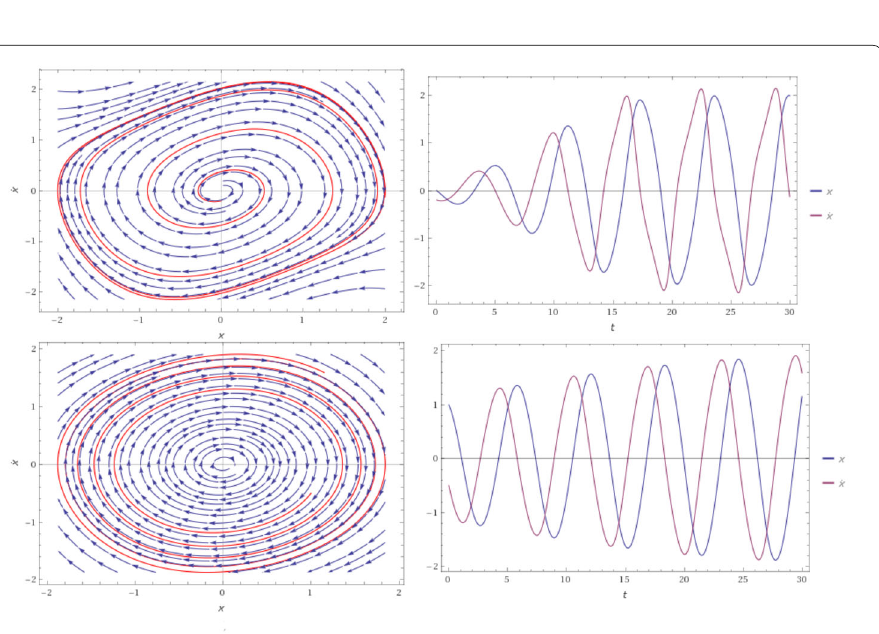
Figure 2 Solutions of (4) for different cases, depending on the value of ρ . We recognize that the cyclic solution for these cases is based on the fact that Q is cyclic